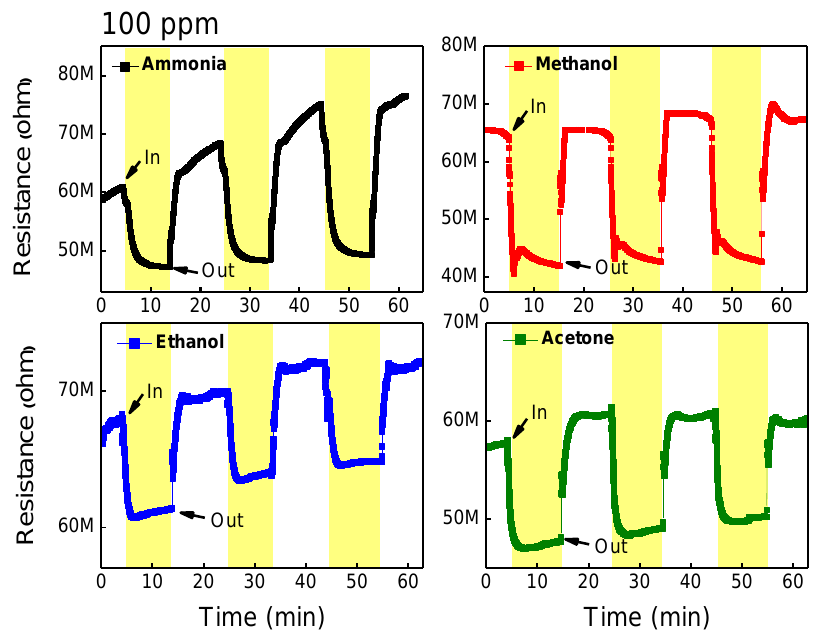
Figure 4. Gas-sensing results of GO/TiO 2 composite film without UV irradiation toward 100 ppm ammonia, methanol, ethanol, and acetone gas bubbling at room temperature (25 °C).